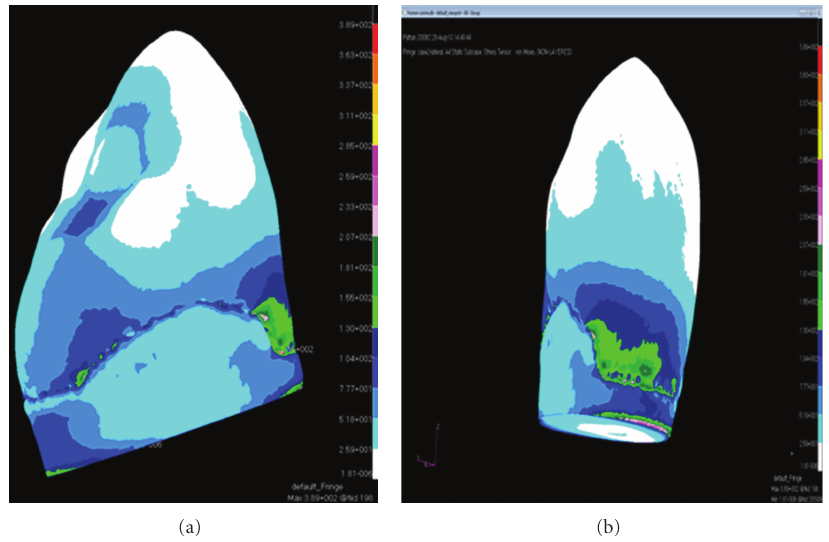
Figure 3: von Mises stress distribution caused by 100N lateral loading ((a) lateral view and (b) buccal view).